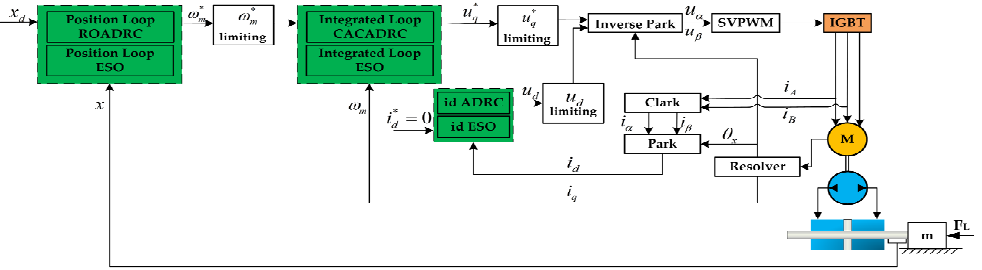
Figure 2. The control architecture diagram of the EHA.